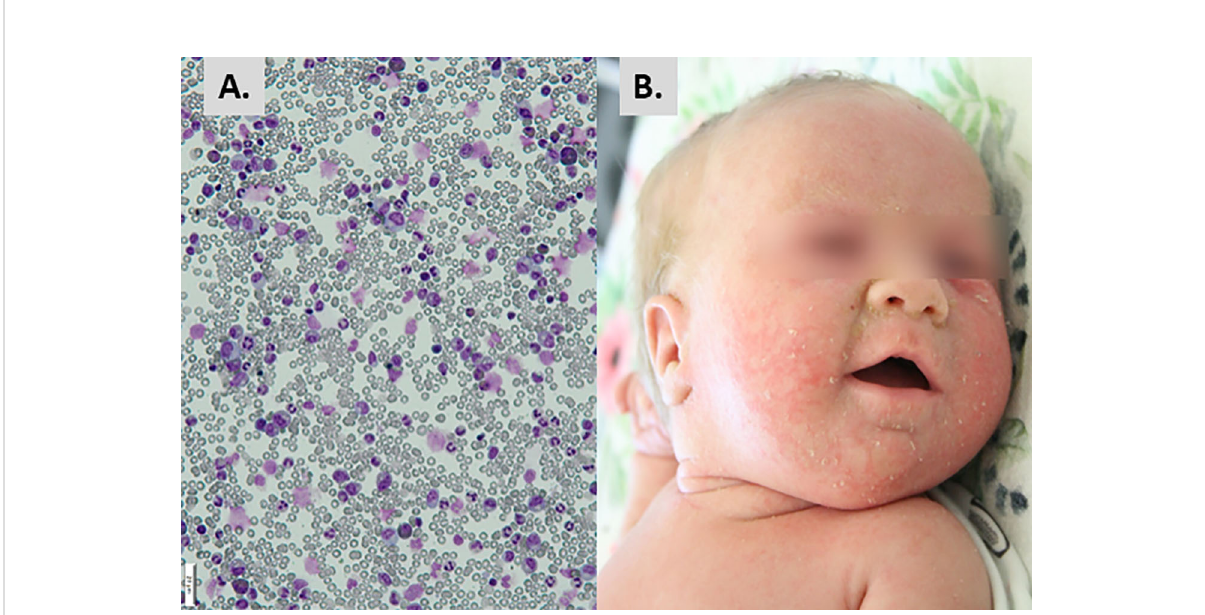
FIGURE 2 Initial presentation and diagnostic hallmarks. (A) Hypercellular bone marrow with suppressed erythroblastic lineage. (B) Erythematous-exfoliative skin